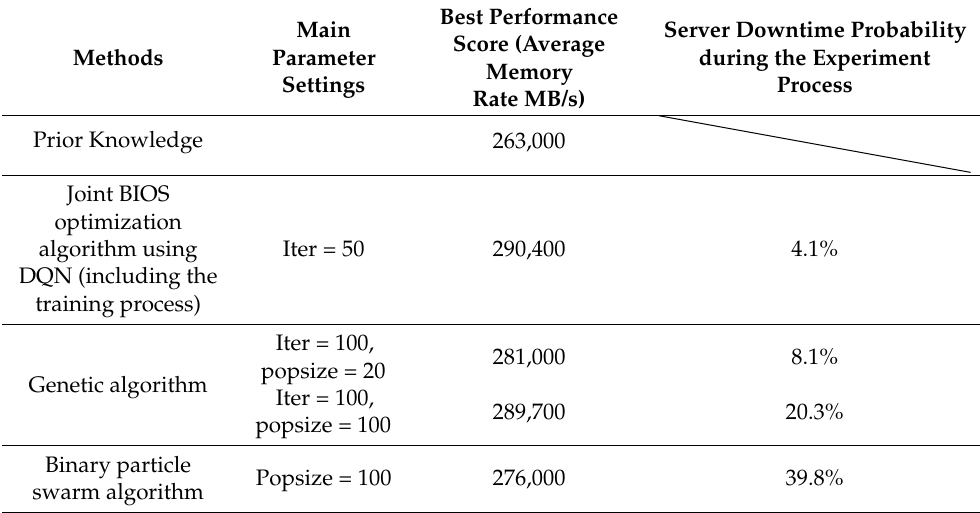
Table 4. Comparison of different algorithm optimization results for the STREAM scenario.